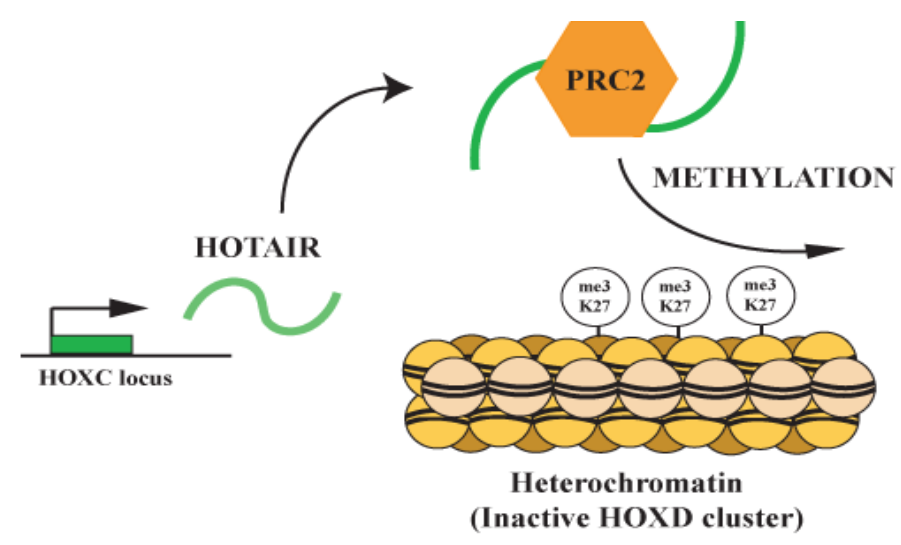
FIGURE 2. The role of the HOTAIR lncRNA in Hox gene regulation. HOTAIR is a lncRNA expressed from the human HOXC cluster, which binds to PRC2 and recruits the complex to the HOXD cluster, leading to H3K27 trimethylation–mediated heterochromatin formation. The two loci are on separate chromosomes, suggesting that the lncRNA works in trans to regulate chromatin structure.